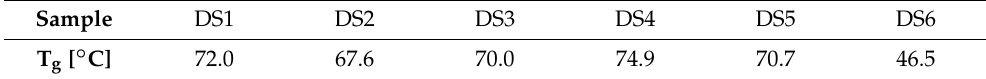
Table 4. Glass transition (Tg) temperatures for the obtained nanocomposites.